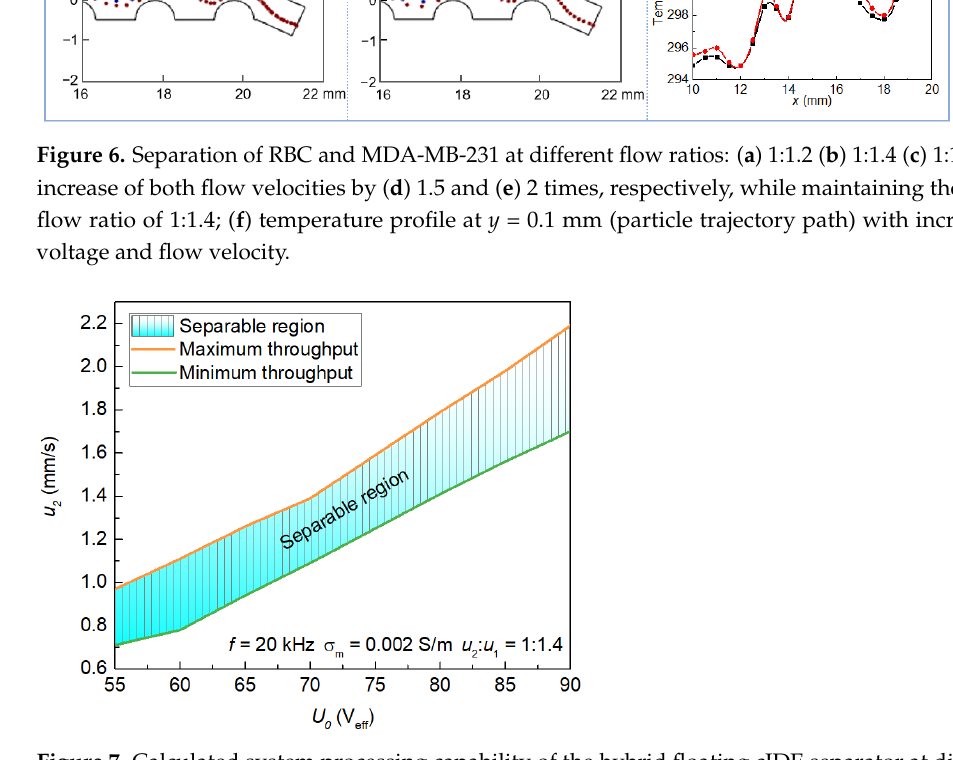
Figure 7. Calculated system processing capability of the hybrid floating cIDE separator at different driving voltage.